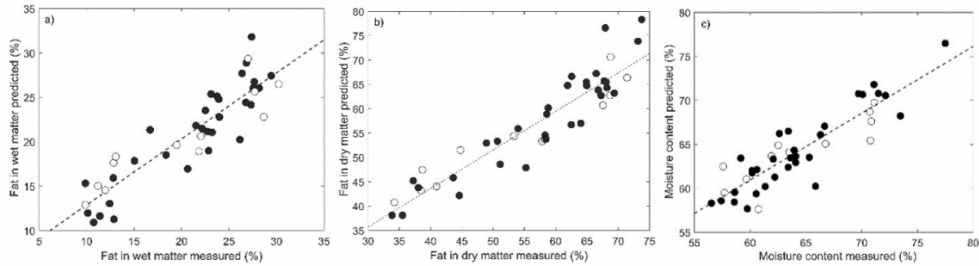
Figure 4. Plots of the reference versus predicted values for the calibration (black circles) and validation (white circles) samples for ( a ) FWM, ( b ) FDM, and ( c ) moisture obtained with CWFP-T 1